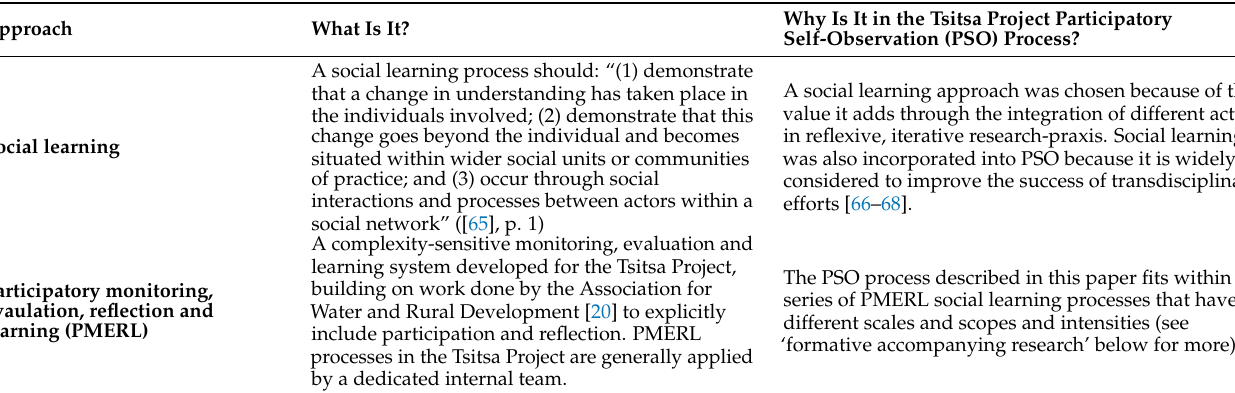
Table 1. The definitions and rationale behind the incorporation of various inter-related approaches as a conceptual tool repository in the participatory self-observation (PSO)